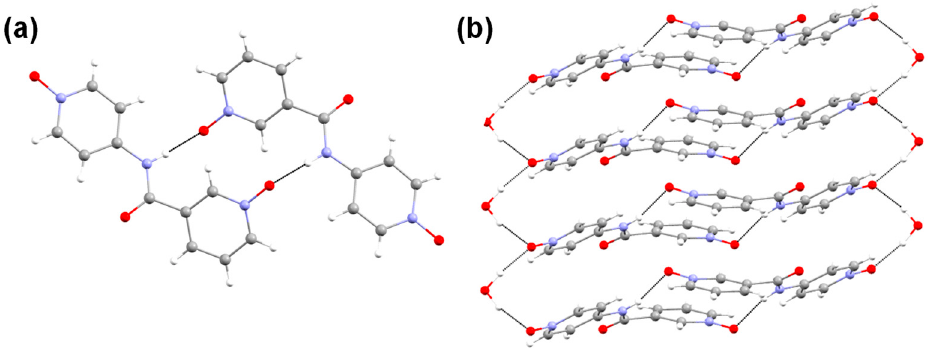
Figure 3. ( a ) Hydrogen-bonded dimer of L 3 stabilized by N–H···O interactions and ( b ) the amino- pyridine N- oxide moiety interacting with the water molecule to form a 1D hydrogen-bonded chain of the